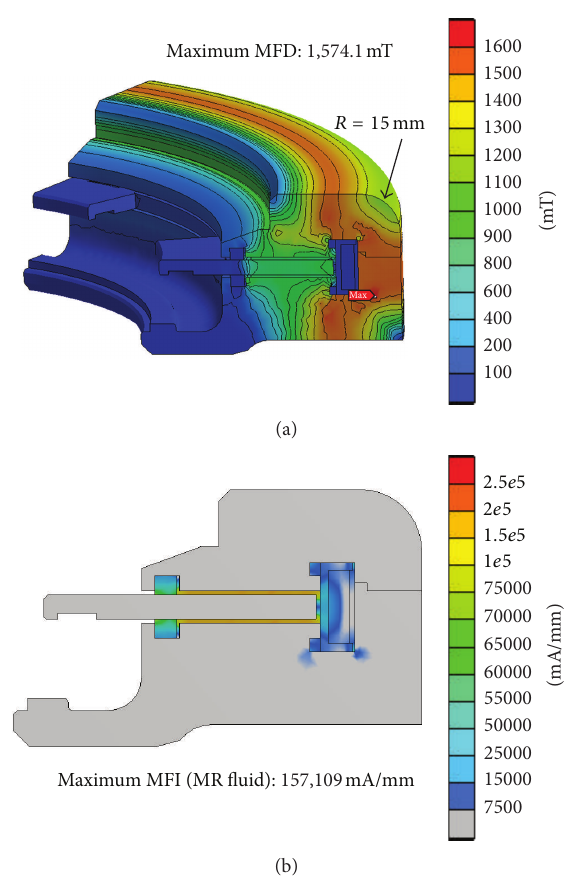
Figure 10: FEA results of the rotary MR damper (Model C, 𝑅 = 15 mm). (a) Magnetic flux density (MFD). (b) Magnetic field intensity (MFI).